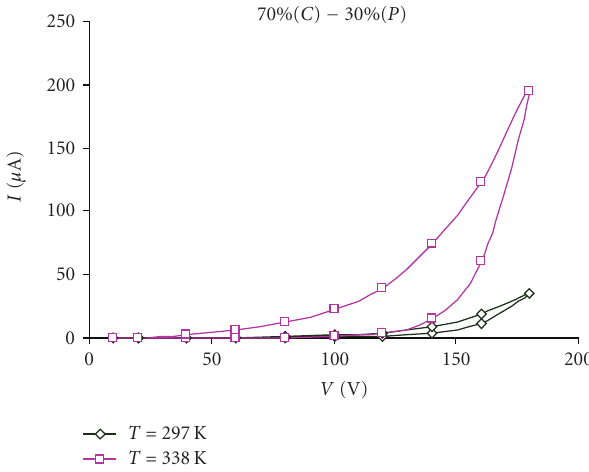
Figure 11: The hysteresis loop for sample